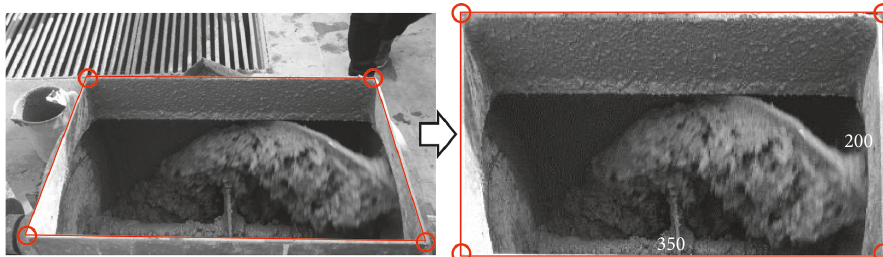
Figure 8: Affine transformation to the images.